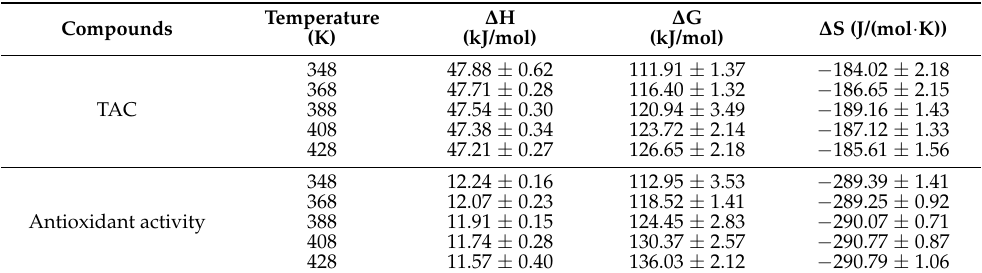
Table 3. Thermodynamic parameters ( ∆ H, ∆ G, and ∆ S) of phytochemical degradation process in red onion skins